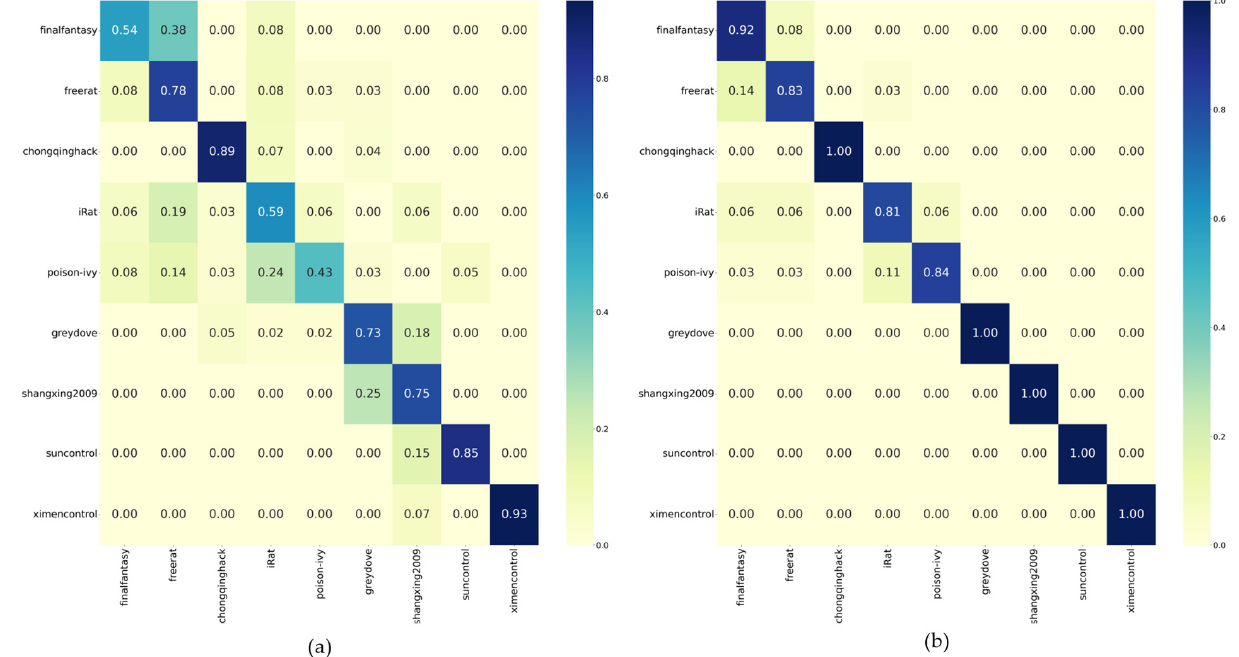
Figure 4. Classification accuracy of small-sample datasets. ( a ) Performance of the direct training model. ( b ) Performance of the DA-Transfer model.